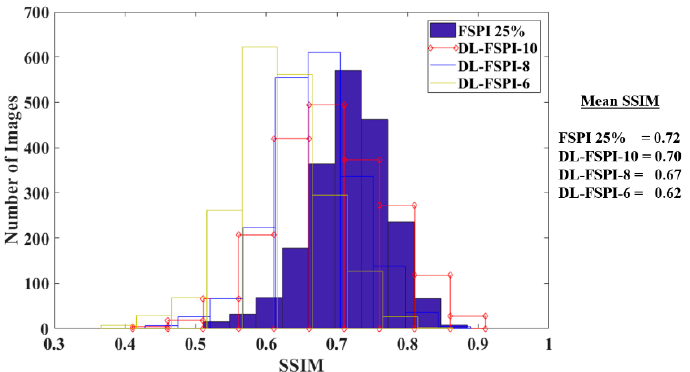
Figure 8. Histograms of SSIM for the validation dataset (2000 images) reconstructed using different methods. Table 1. Experimntal Imaging time for FSPI and DL-FSPI.